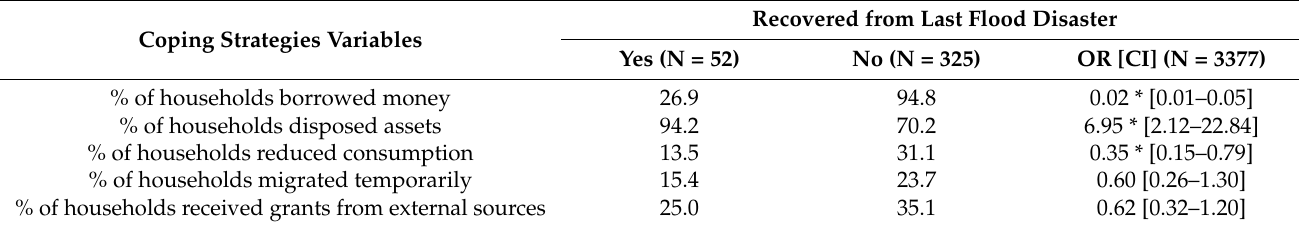
Recovered from Last Flood